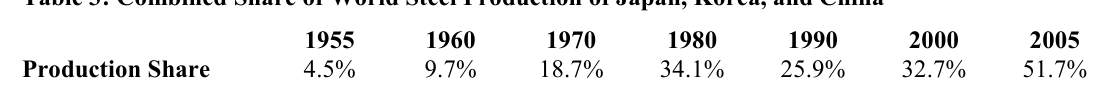
Table 3: Combined Share of World Steel Production of Japan, Korea, and China 1955 Production Share Source: IISI and adjusted Table from Shin and Yoo